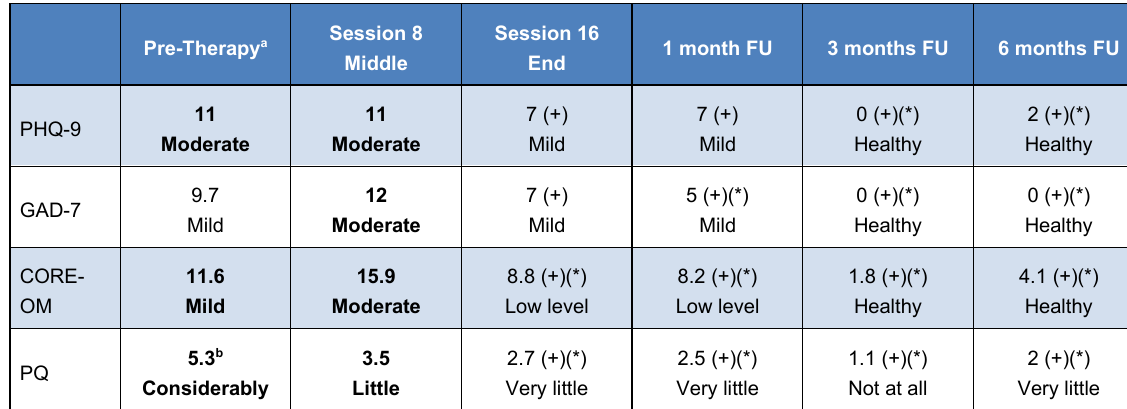
Table 1. The initial depressive score (PHQ-9, 11) indicated a moderate level of depression. The initial anxiety score (GAD-7, 9.7) indicated a mild level of anxiety. The global distress score (CORE, 11.6) indicated a mild level of global distress and functional impairment. The severity score of personal problems (PQ, 5.3) indicated that the client perceived her problems as bothering her more than considerably.